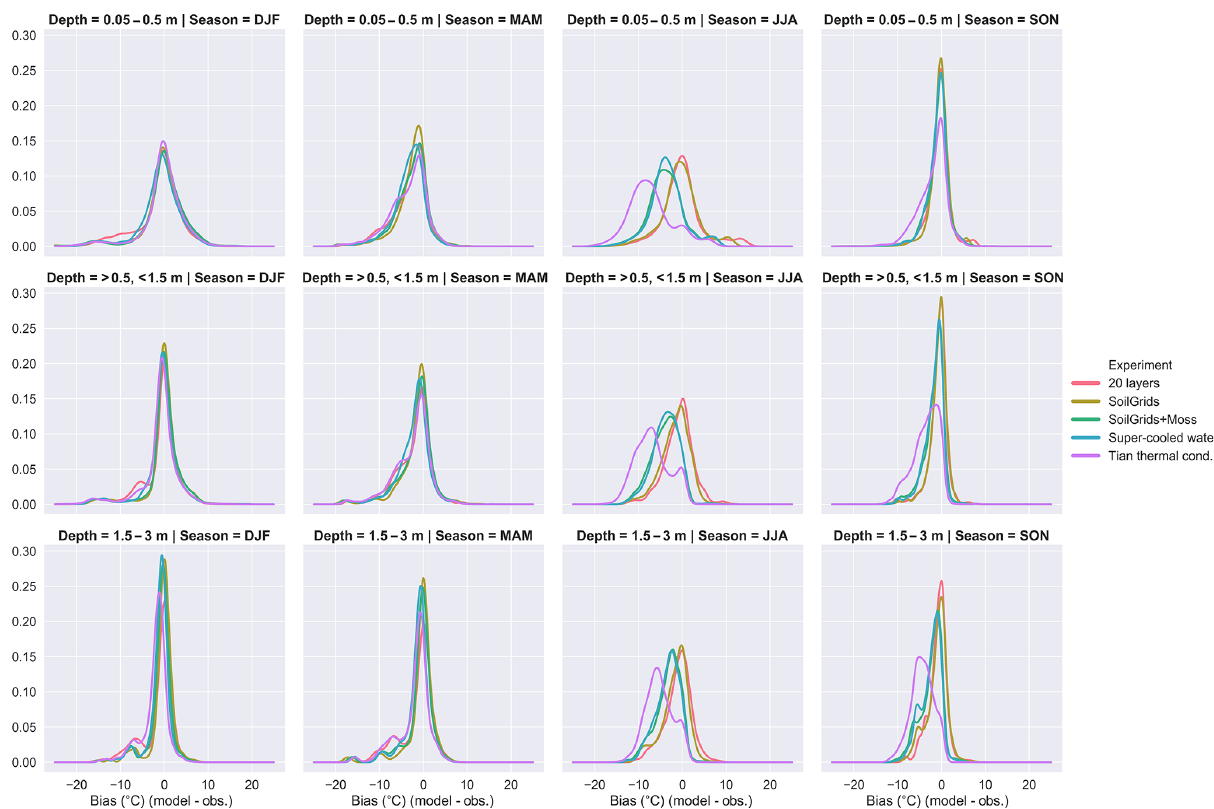
Figure 5. Gaussian kernel density estimates for the difference between the simulated ground temperatures and those of the GTN-P borehole temperature sites (Table S2) for three depths: 0.05–0.5, 0.5–1.5, and 1.5–3.0m, for each season and for selected experiments. The bandwidth was chosen using Scott’s rule of thumb (Scott,